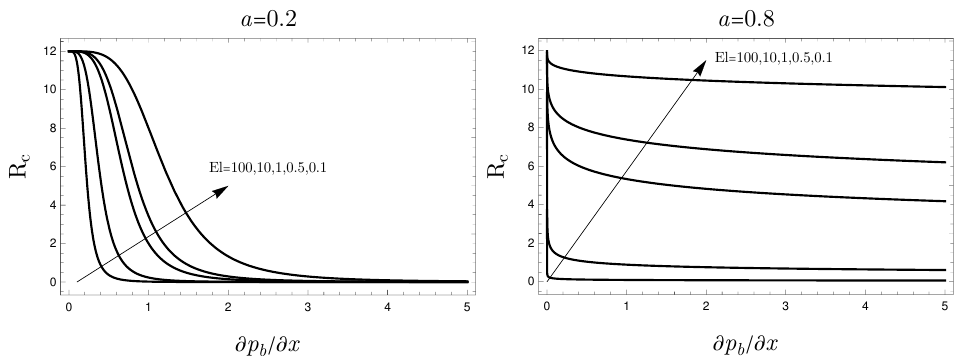
Figure 5. Critical R as a function of the basic pressure gradient for different values of El for a = 0.2 and a =